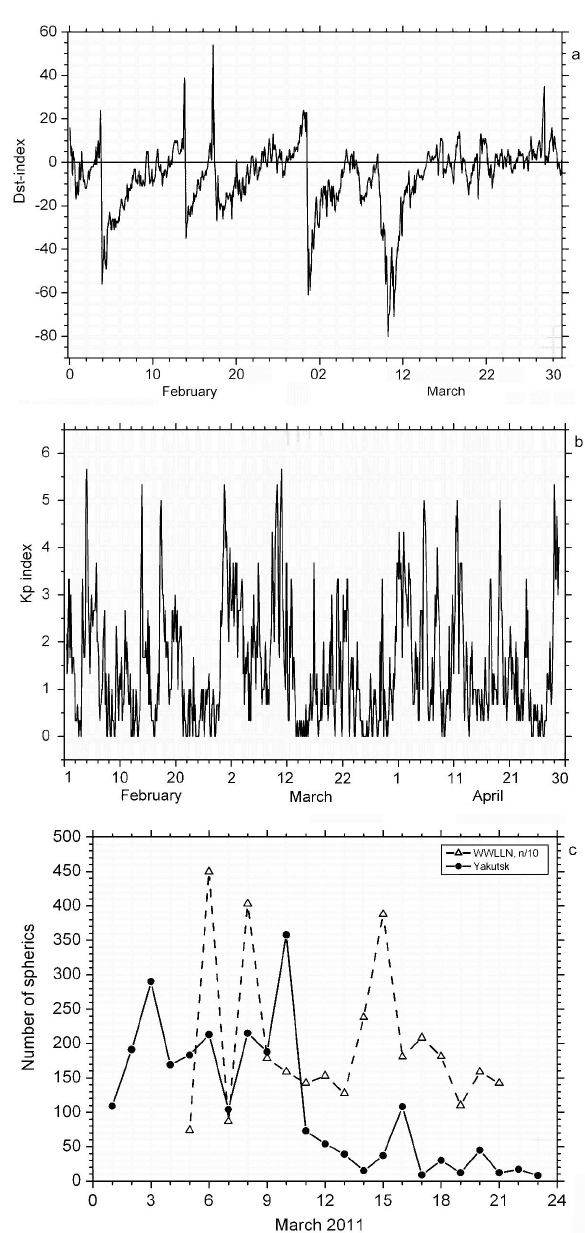
Fig. 5. The behavior of Dst (a) and three-hourly Kp indices (b) dur- ing the considered seismic period. The number of atmospherics re- ceived in Yakutsk in the time interval of 07:00–08:00 UT on March 2011, and the number of atmospherics registered by the WWLLN system in that interval (c)